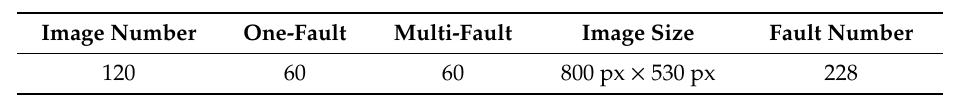
Table 3. The insulator faults